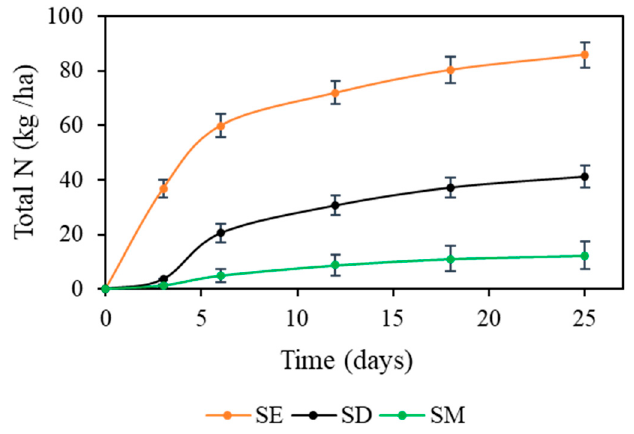
Figure 5. Cumulative leached amount of NH 4 + -N, NO 3 − -N, NO 2 − -N (kg N / ha) in soil treated with synthetic fertilizer (SE), liquid digestate (SD) and microalgae biomass (SM). For each condition, the lixiviation due to the control (soil alone) have been subtracted.